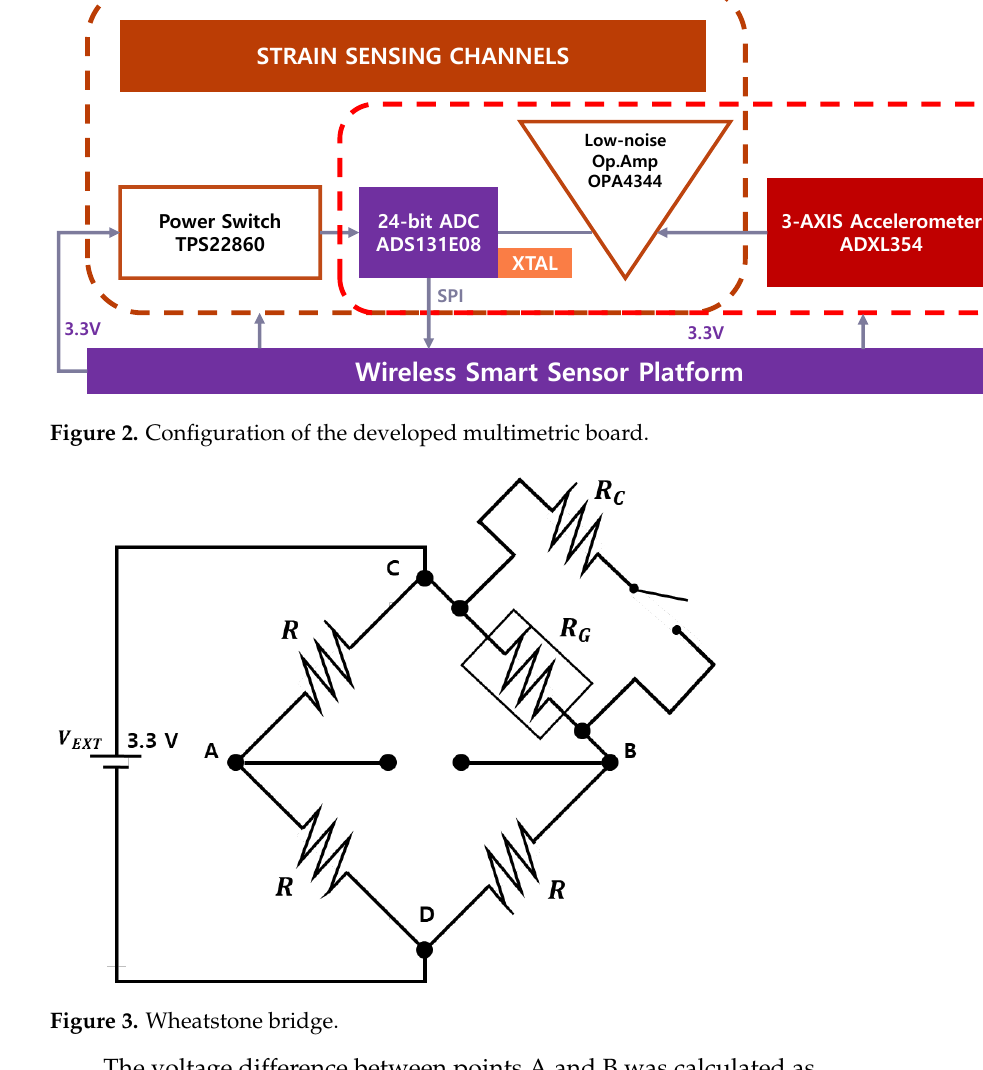
Figure 3. Wheatstone bridge.